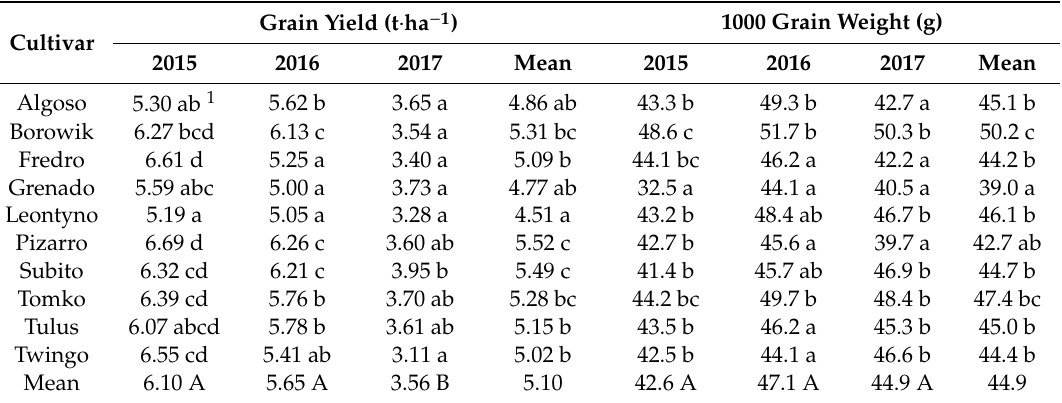
Table 8. Yields and 1000 grain weight (TGW) of triticale cultivars in the organic system. Cultivar